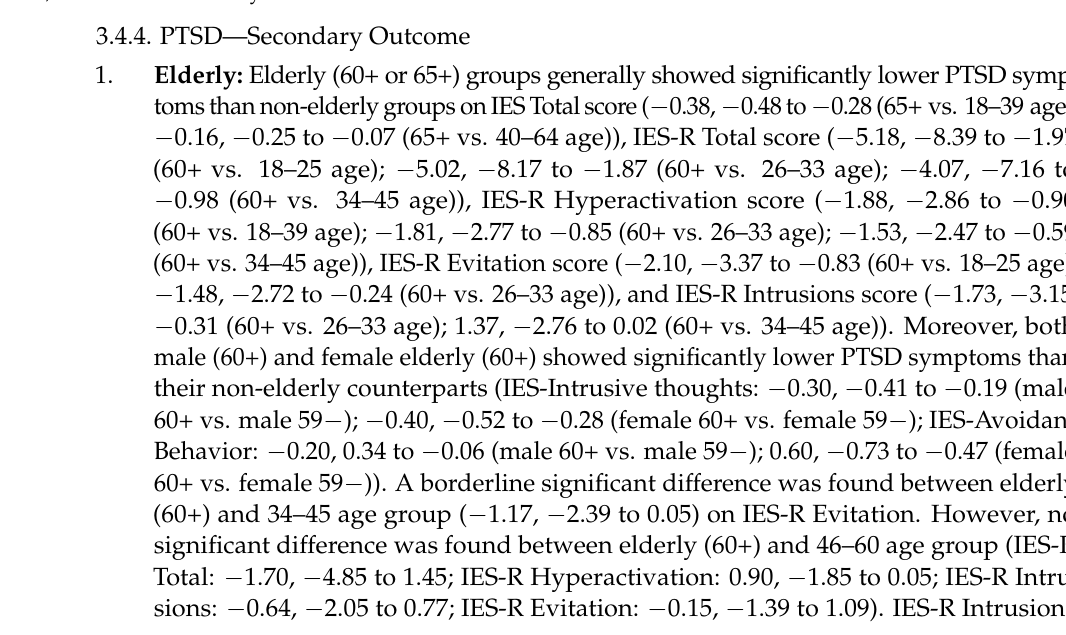
Figure 3. Anxiety symptoms in vulnerable groups during COVID-19. Abbreviations . DASS-21, Depression, Anxiety, and Stress Scale-21; GAD-7, Generalized Anxiety Disorder Scale-7.